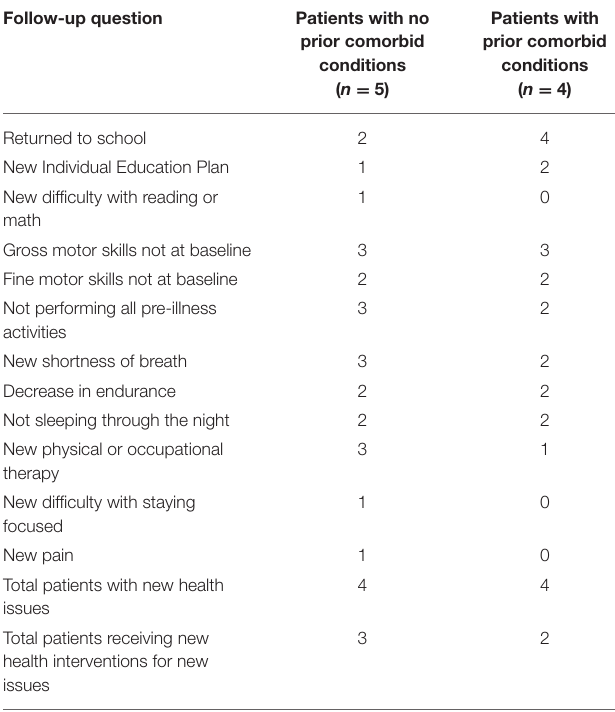
TABLE 3 | Follow-up results in previously healthy patients vs. patients with comorbid conditions. Follow-up question Patients with no